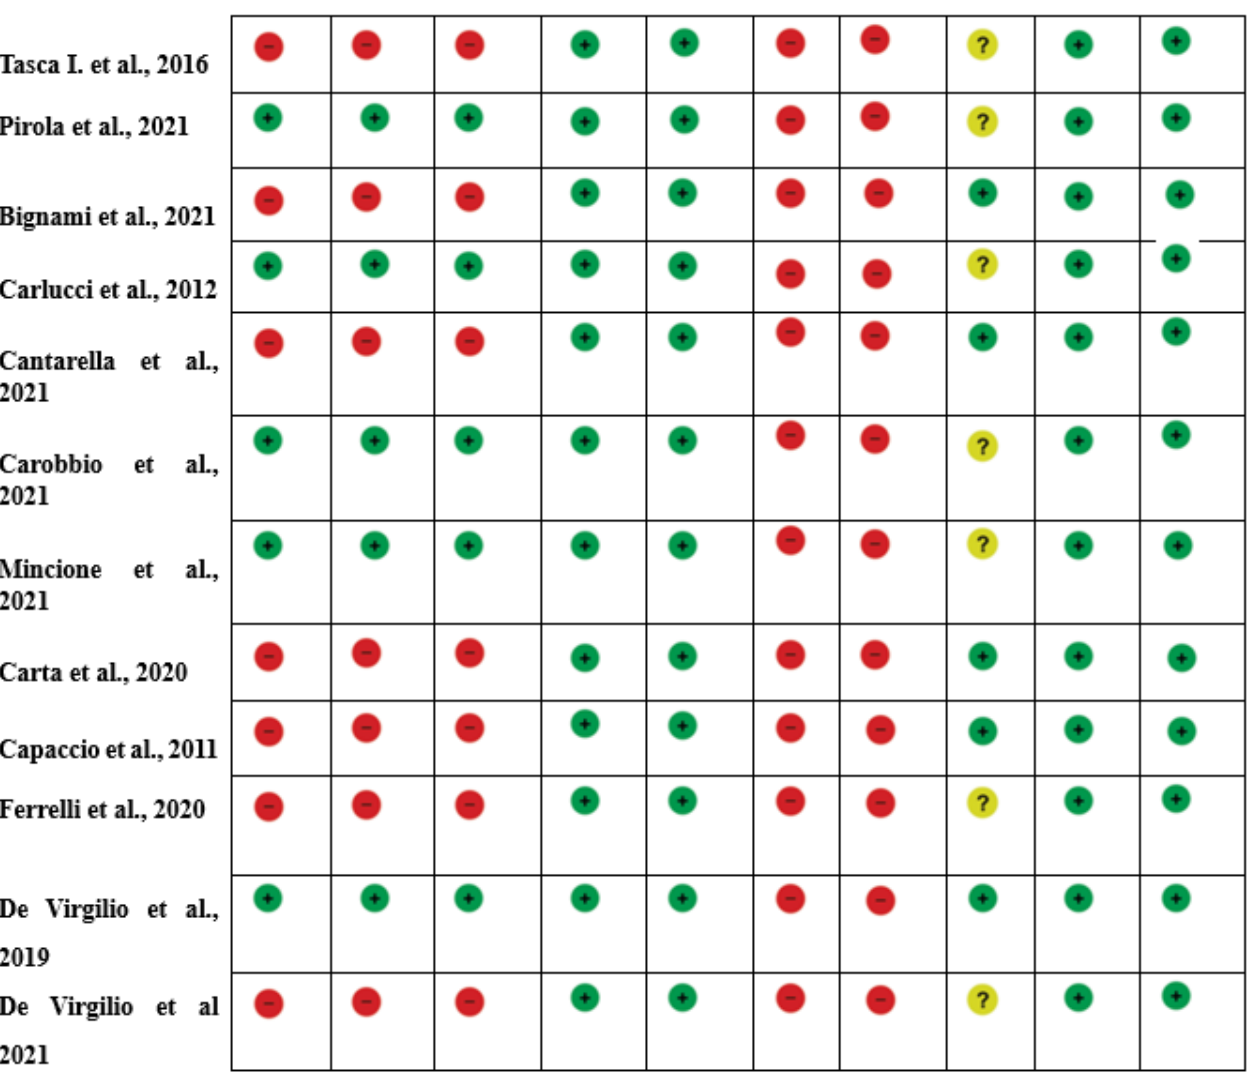
Figure 2. Risk of Bias summary of authors’ judgments for each study, assessed by the Joanna Briggs Institute (J.B.I.) Critical Appraisal Checklist for Case-Control studies [1,2,4,5,14–31] .